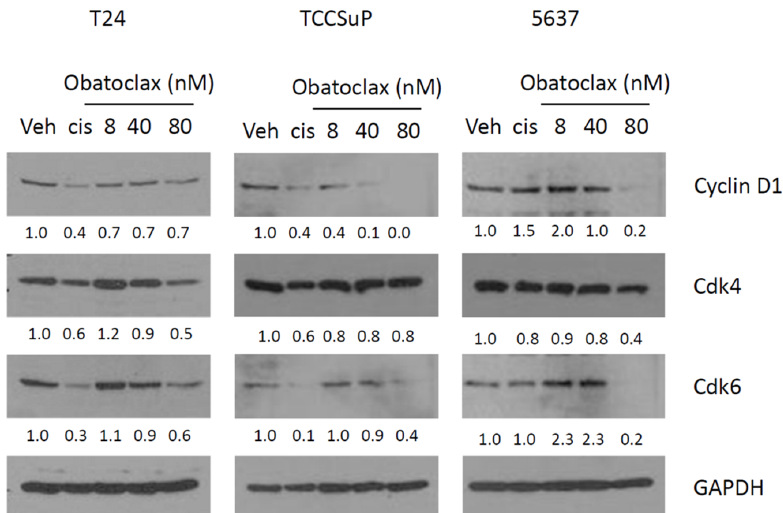
Figure 5. Dose curve experiments confirm that Obatoclax can cause the decreased expression of cyclin D1 and Cdk4/6. Treatment with Obatoclax caused dose-dependent reductions in the expression of cyclin D1 in TCCSuP and 5637 cells. In T24 cells, the highest dose of Obatoclax (80 nM) caused a slight reduction in cyclin D1 expression. A clear dose-dependent reduction in Cdk6 expression levels was observed in all three cell lines, while dose-dependent reductions in Cdk4 expression levels were observed in T24 and 5637 cells. (Veh = vehicle control, Cis = cisplatin).